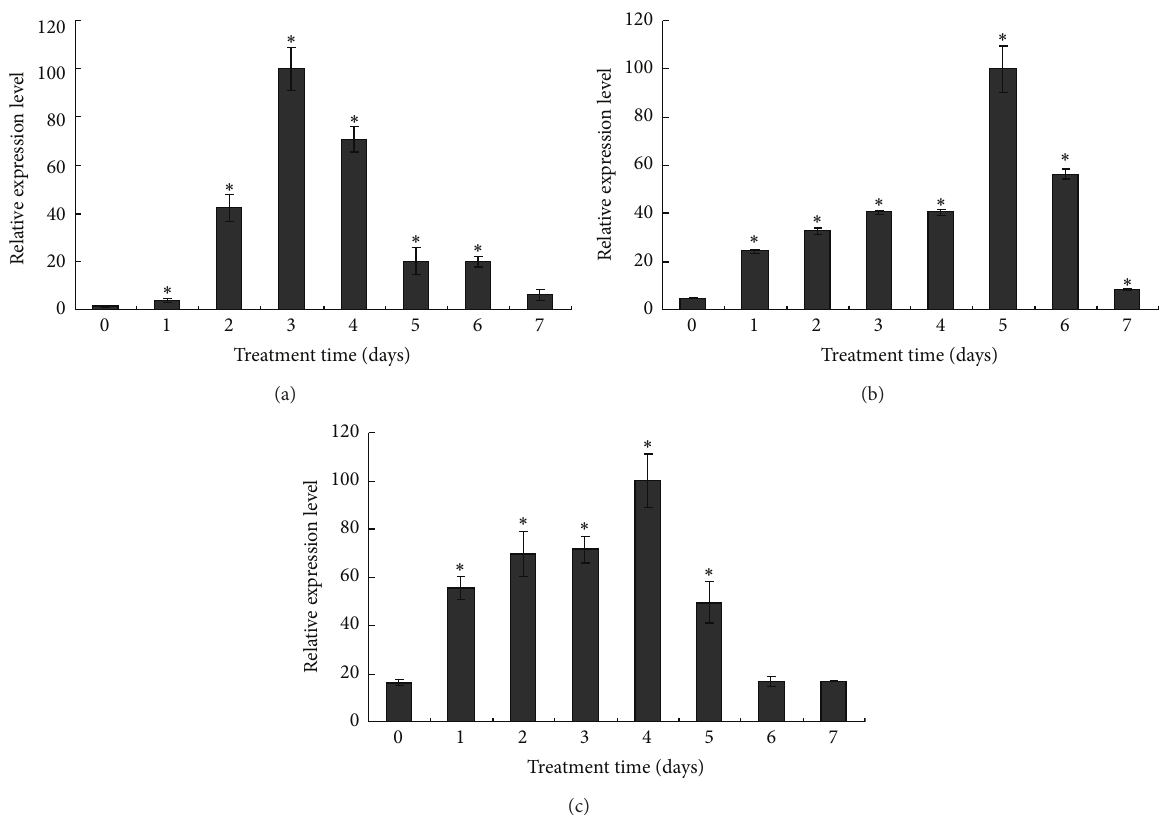
Figure 4: Relative transcript levels of LsCAT (a), LsAPX (b), and LsGPX (c) in L. sinense under 500 mM NaCl treatment. Transcript level of eachgenewasnormalizedtothatof LsActin .Valuesareaveragerelativeexpressionlevelfromthreebiologicalreplicates. ∗ Significantdifference between NaCl-treated and untreated sample ( 𝑃 < 0.05 ).